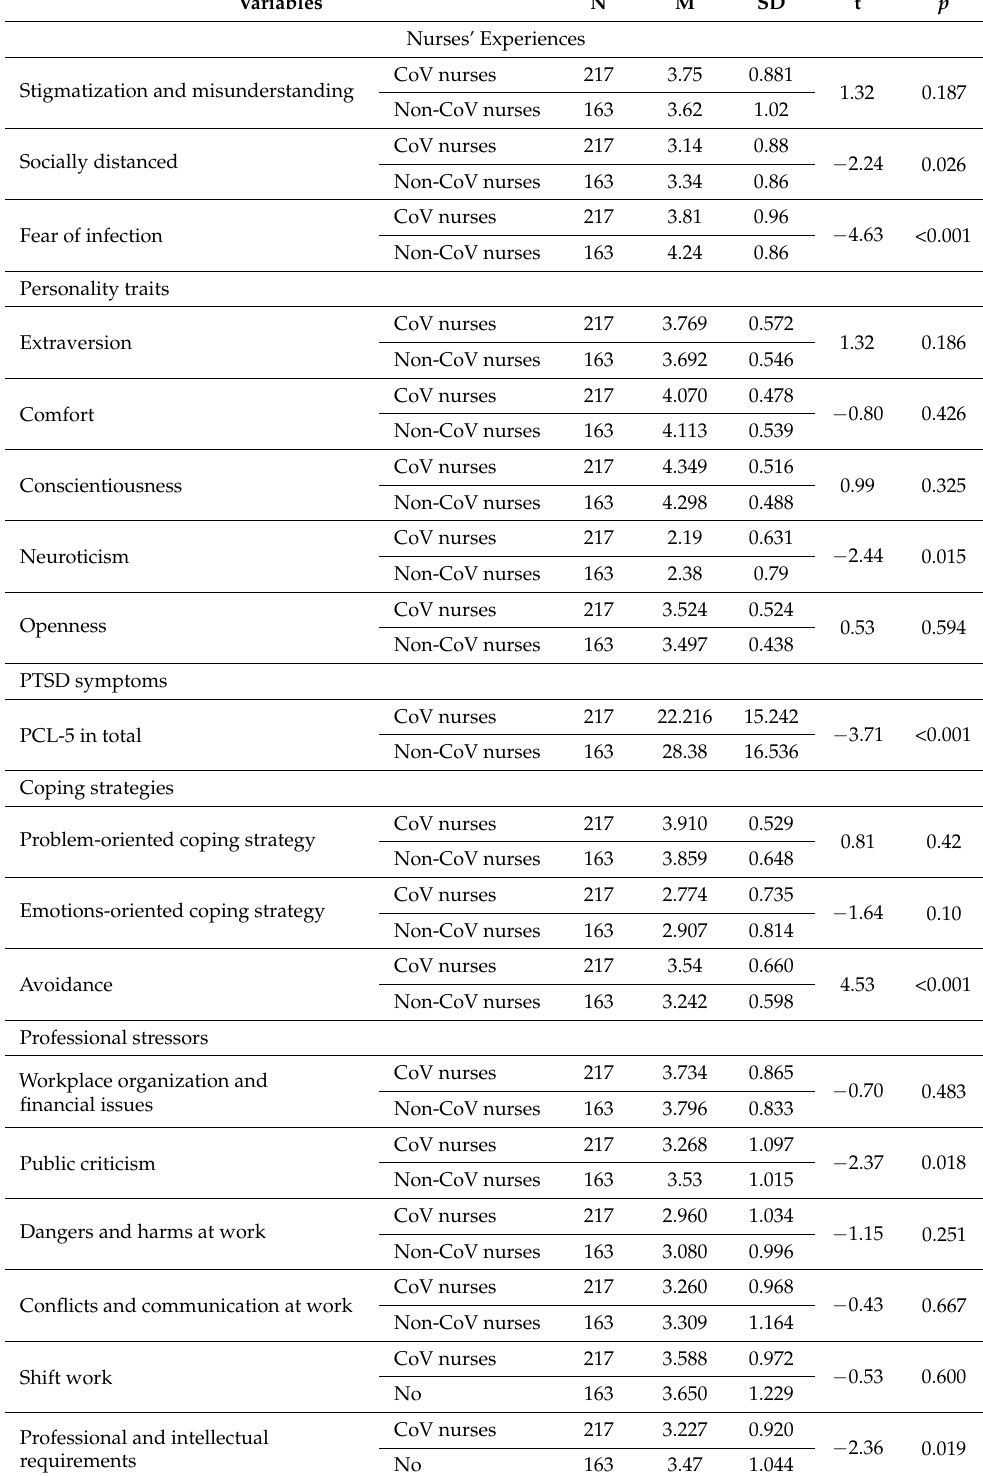
Table 2. Differences in pandemic experiences, psychological characteristics and psychological symp- toms between nurses who worked in COVID-19 and non-COVID-19